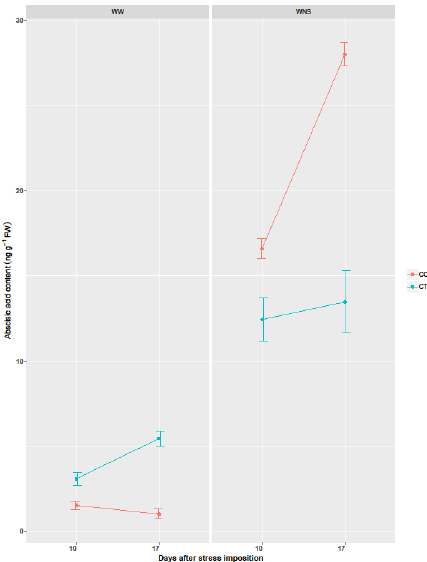
Figure 3. Changes in total endogenous ABA concentrations in leaves of wheat plants either well-watered and water / nutrient stressed, WW: Well watered; WNS: Water / nutrient stress; CC: Coated control; CT: Coated with thyme oil.